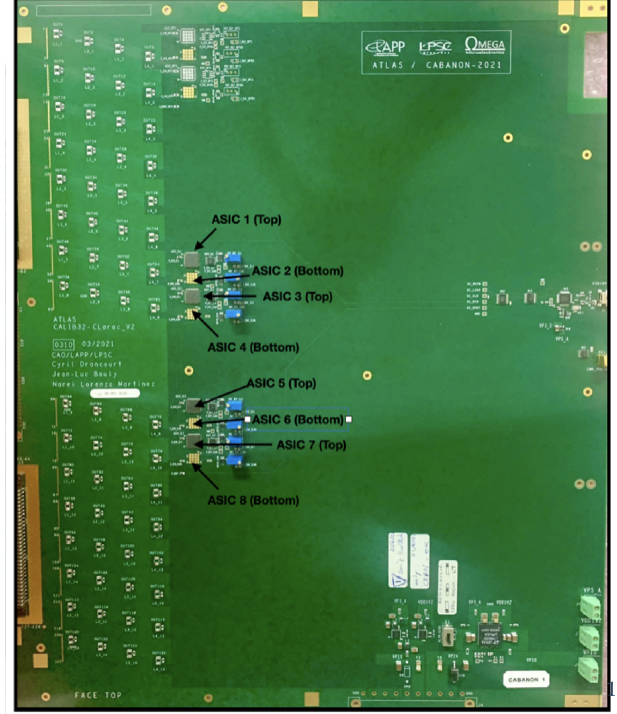
Figure 7. Image of the CABANON pre-prototype test calibration board, with ASIC locations